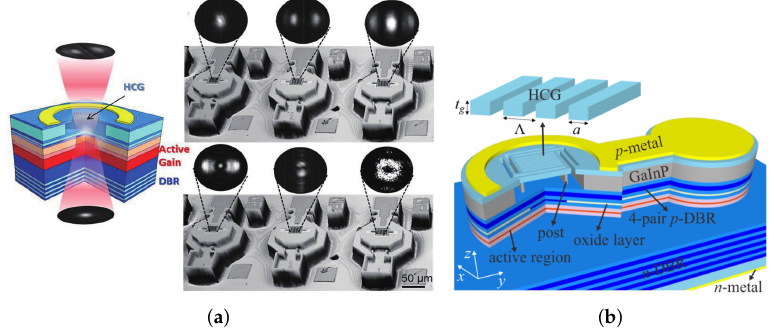
Figure 7. ( a ) Double-sided VCSEL structure and its beam shaping effect [58]; ( b ) schematics of the 940 nm HCG-VCSEL